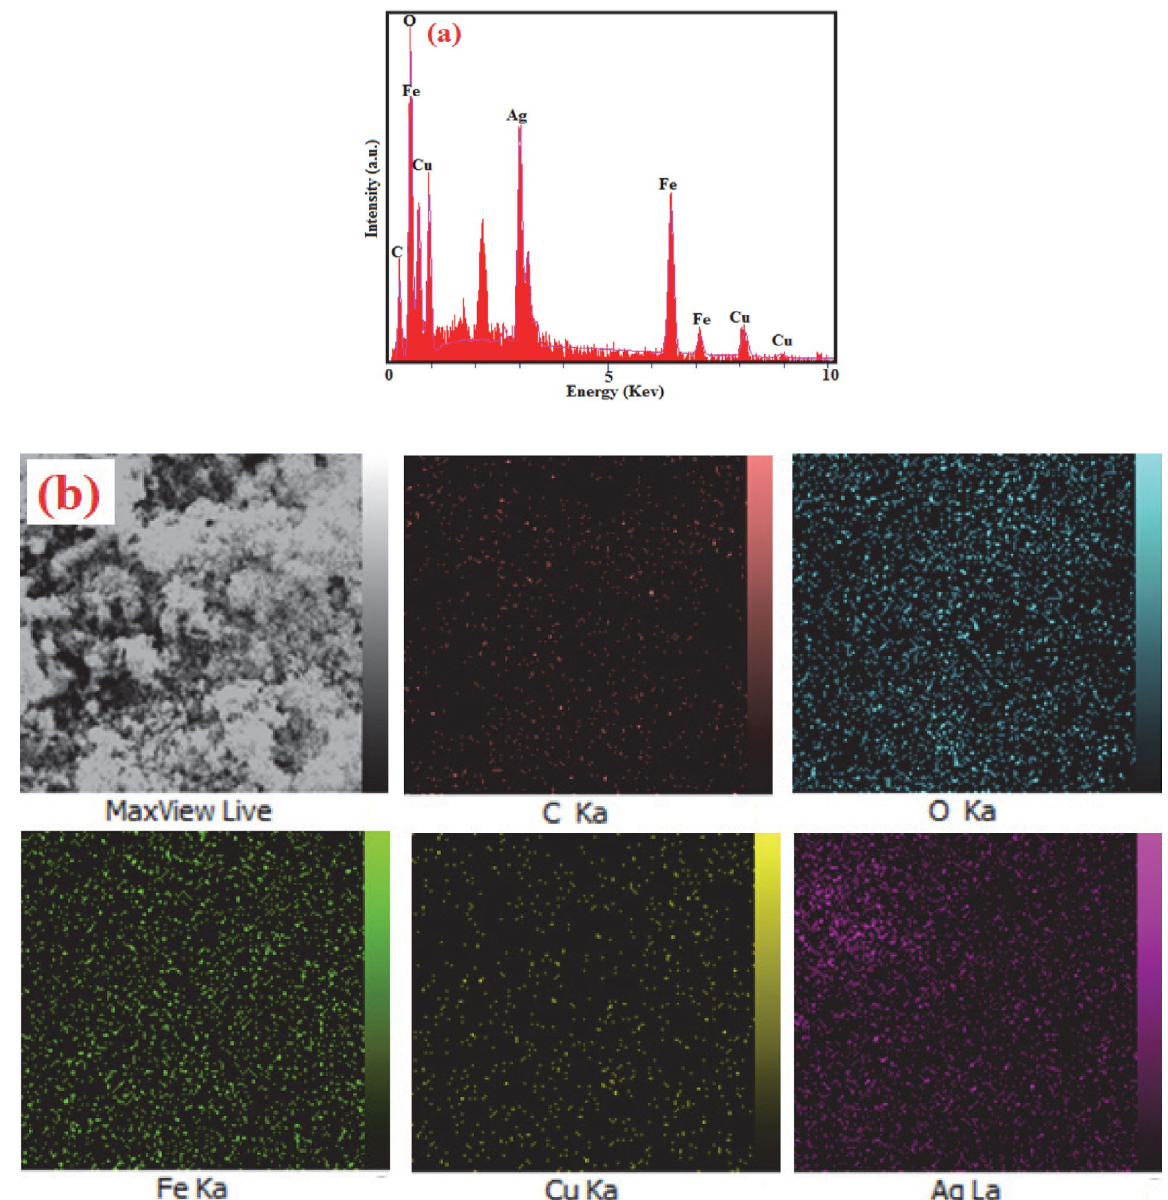
Figure 4. (a) EDX spectrum and (b) a representative SEM image with corresponding EDX elemental mappings of the Ag/CuFe 2 O 4 /rGO nanocom-